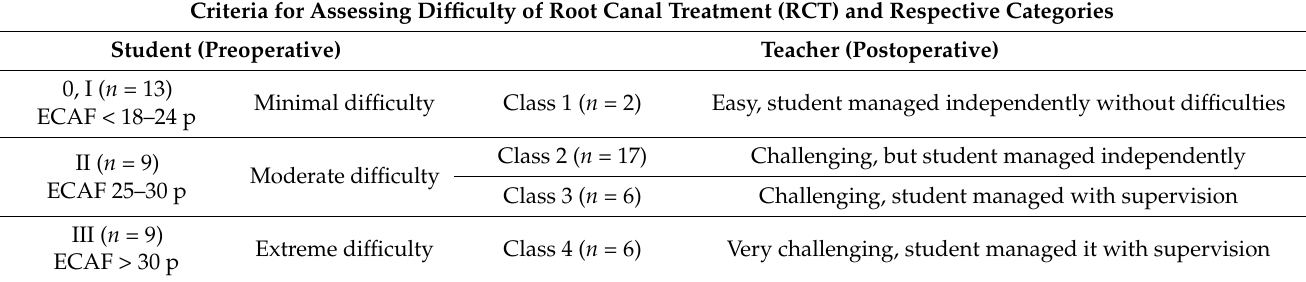
Table 1. Criteria of the teacher’s difficulty assessments and corresponding assessments by dental students. Criteria for Assessing Difficulty of Root Canal Treatment (RCT) and Respective Categories Student